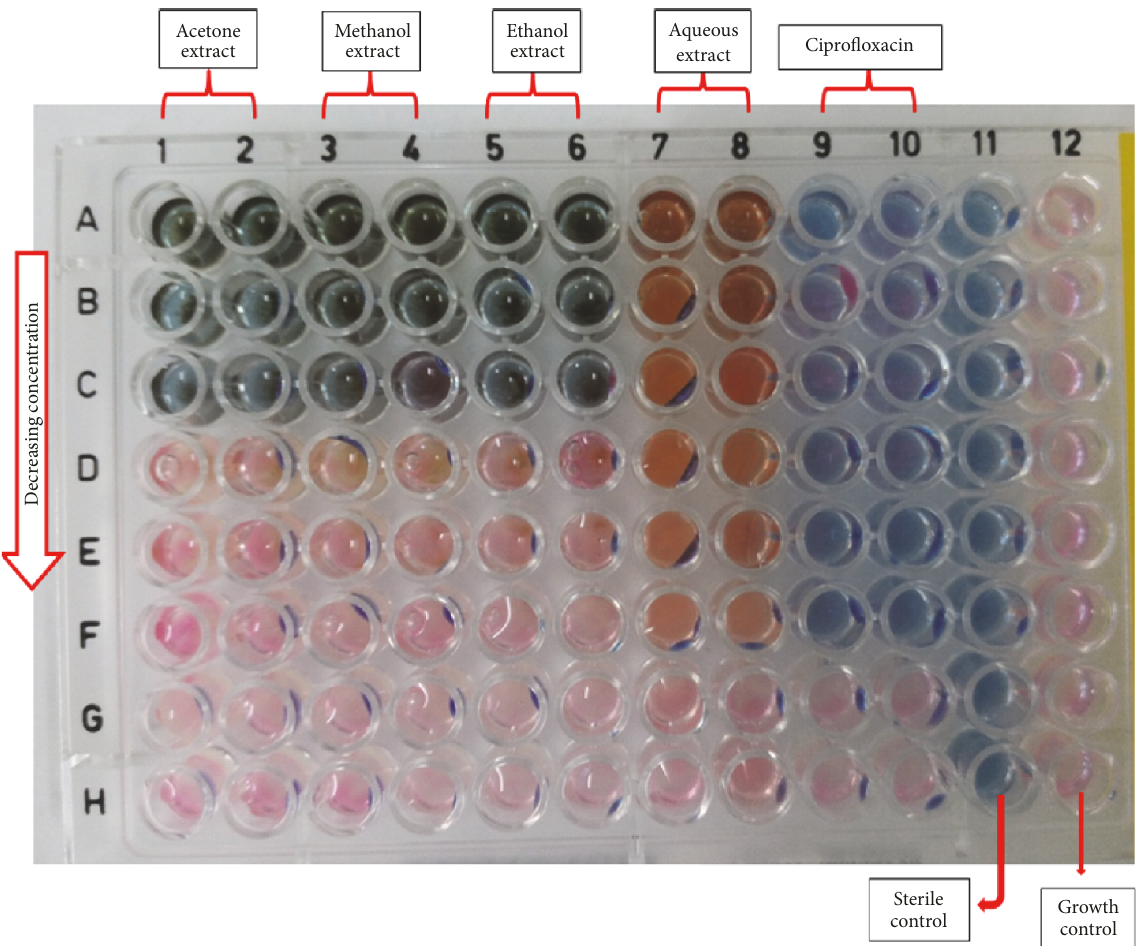
Figure 1: A schematic representation of the 96-well resazurin broth microdilution model . Annotations: The blue colouration indicates inhibition of growth; pink indicates that organisms are active. The different shades of blue and pink colours in columns 1–8 as compared to columns 9–12 are due to the different extracts